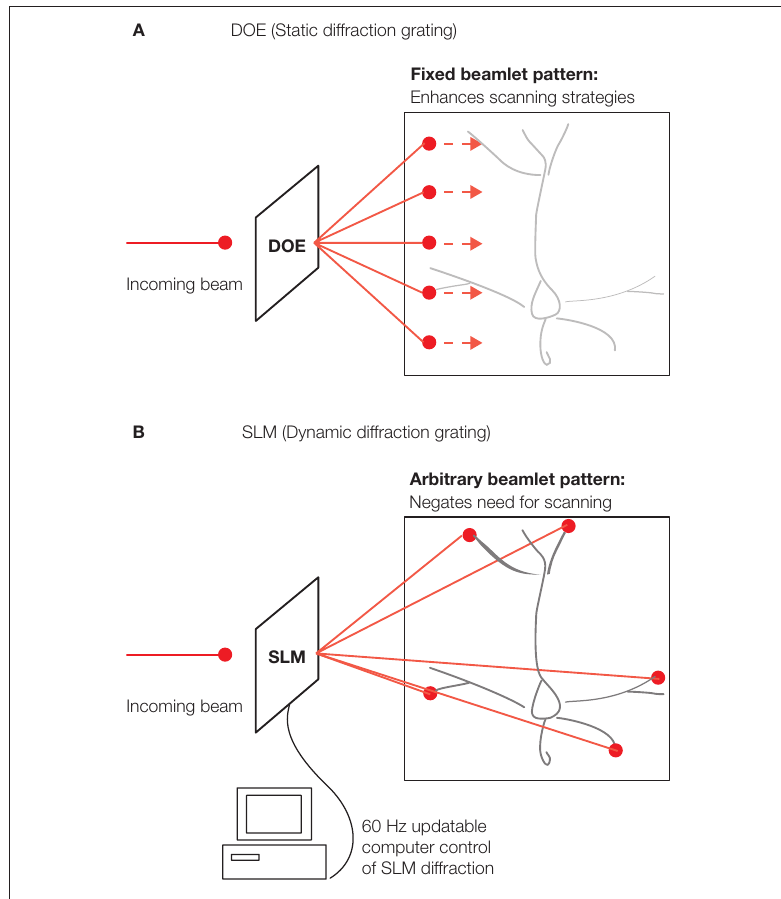
Figure 1 | Multibeam two-photon excitation with diffractive optical elements (DOe) or spatial light modulators (SLM). Both the DOE and the SLM use diffraction to create an output pattern of multiple beamlets of light from a single input beam. (A) DOE is a static diffraction grating which creates a single particular output pattern, in this case a linear array of evenly spaced beamlets. These beamlets can be used to increase speed and/or increase sampling of imaging given that they allow for simultaneous exposure of multiple full power excitation points either in parallel or in series over portions of the field. (B) The SLM is dynamically controllable via computer and can create arbitrary patterns of output light to fit the spatial aspects of particular imaging fields (i.e., targeting particular neurites or cells). Furthermore, the SLM can have a new diffraction grating pattern thereby creating a new output pattern of beamlets every 16.7 ms (or even faster depending on type of the used SLM). SLMs allow scanless microscopy for both imaging as well as photostimulation experiments all at multiple spatial points